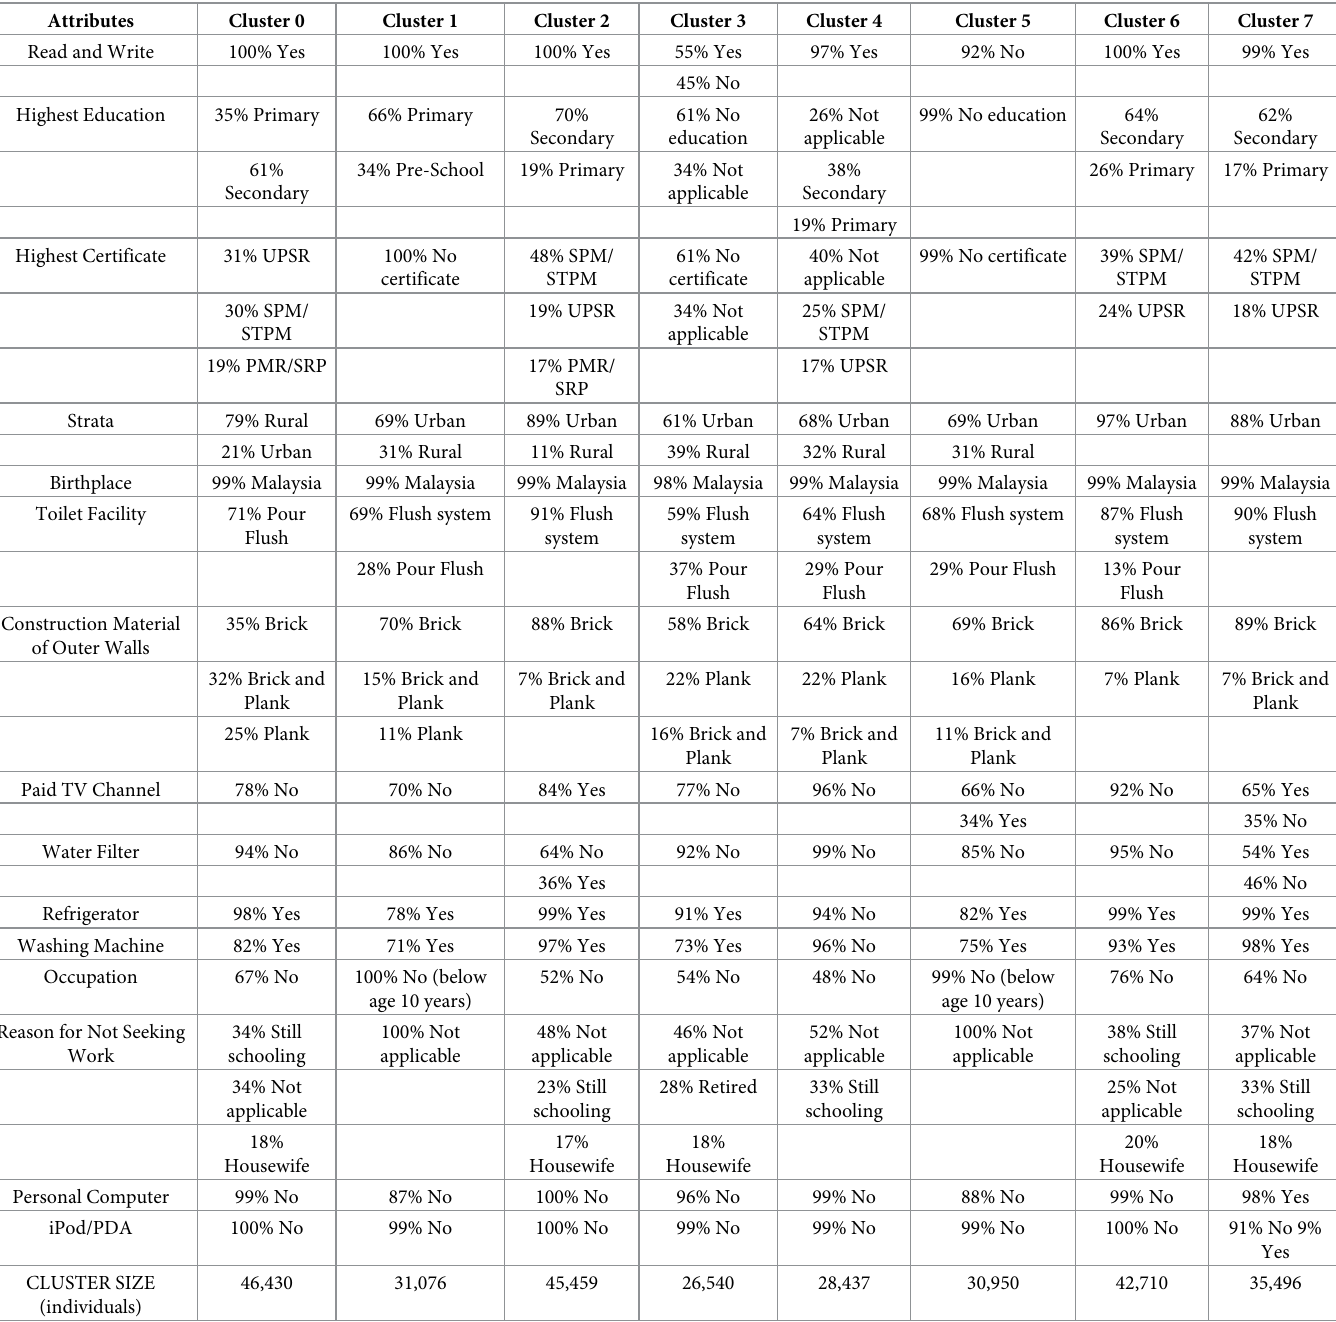
Table 10. Descriptive statistics for B40 clustering